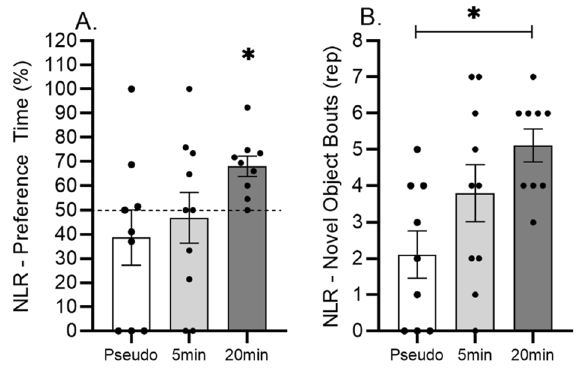
Figure 3. Effects of 5 and 20 min daily sessions of WBV on spatial memory in spatial object relocation test (NLR). Preference time in % (panel A ) and frequency of novel object exploration (panel B ). One-way ANOVA was used for reveiling the difference between the experimental groups. Further, independent T-test was used for comparing preference time to the 50% chance level (dashed line). Data are depicted as mean ± SEM. * indicates P < .05.